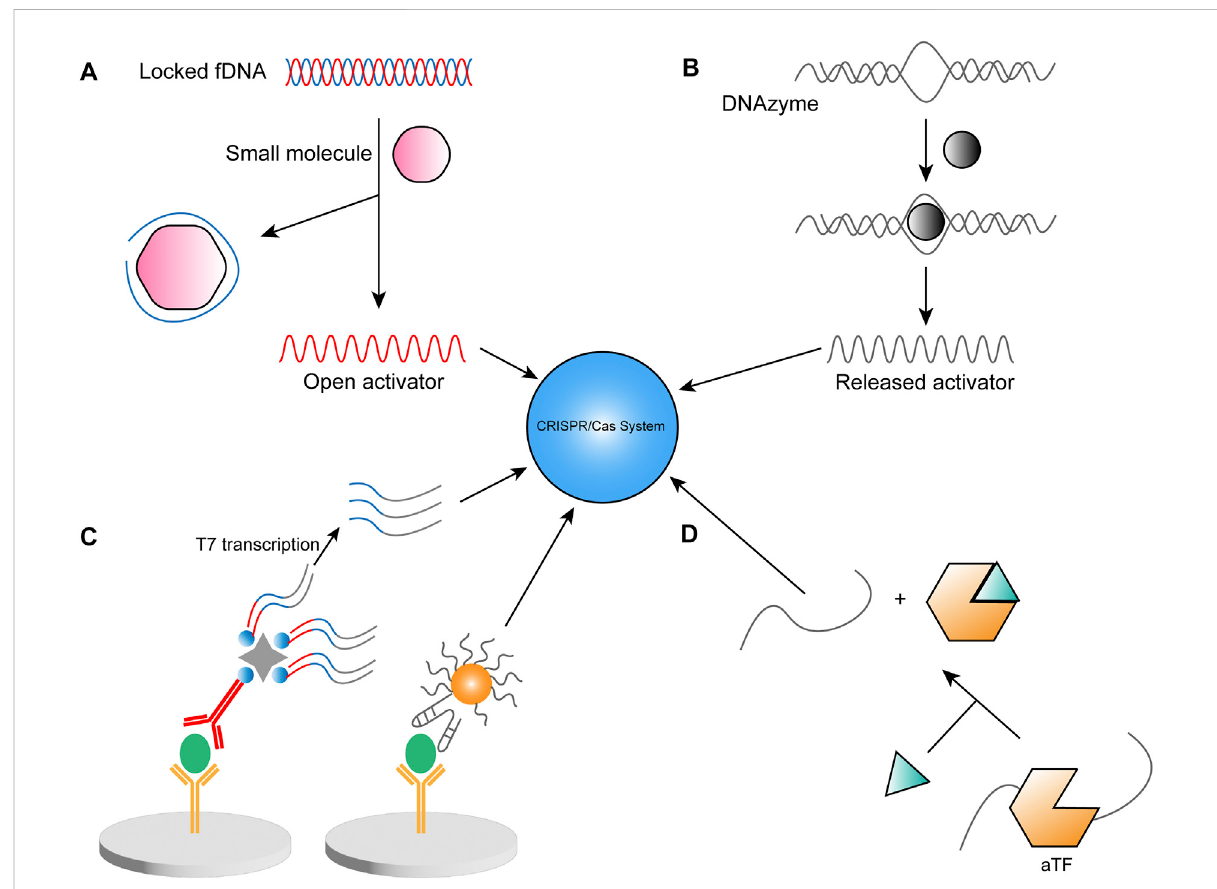
FIGURE 4 StrategiesforCRISPR-basednon-nucleic-aciddetection. (A) LockedfDNAinthepresenceofasmallmolecule,onestrandbindstoit.Itreleases another complementary DNA strand to participate in the detection reaction (B) The DNAzyme starts in an inactive state and activates its cleavage ability with the involvement of speci fi c ions, thus releasing short strands of DNA to participate in the detection system. (C) Left: Non-nucleic acid as antigen,linkedtotheCRISPR/Cassystemandantibody(yellow)-antigen(green)-antibody(red)structurebyanucleicacidsequencecontaining the T7 promoter. Right: DNA-AuNP is used instead of antibody and is directly involved in the assay reaction. (D) Immobilized aTF-dsDNA complexes containing CRISPR target sequences change the conformation in the presence of aTF target small molecules, resulting in the release of